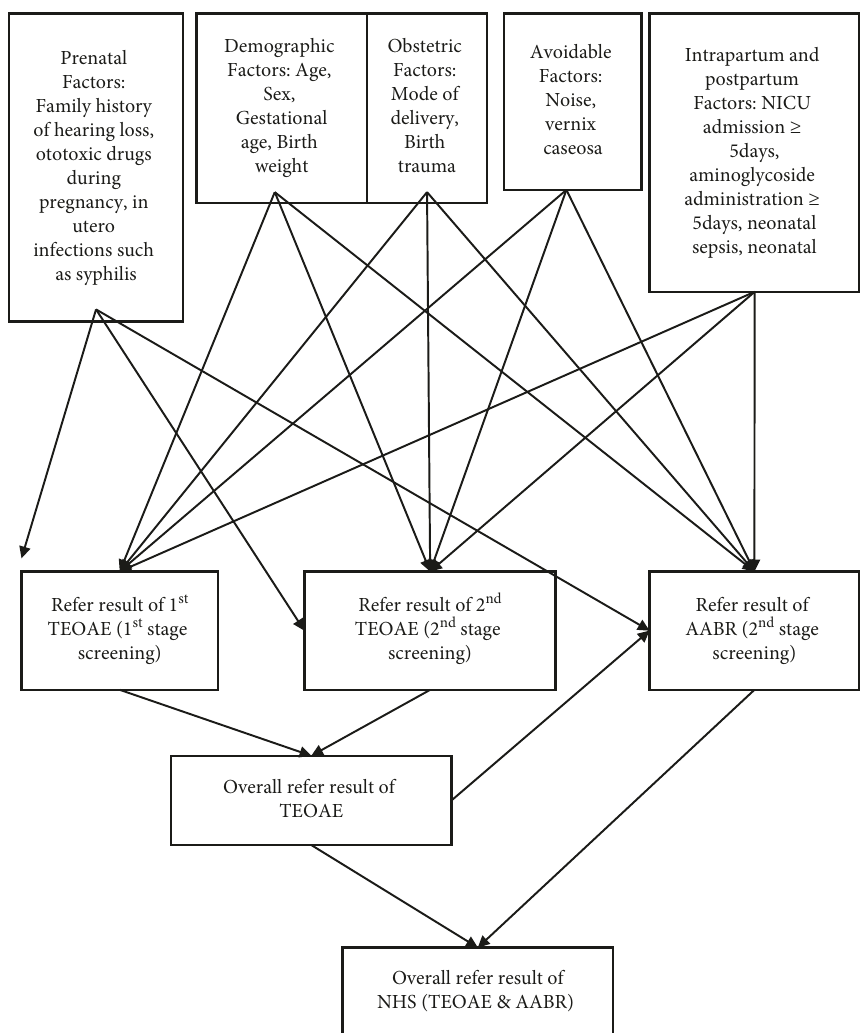
Figure 1: Data collection tool includes semi-structured questionnaire which includes demographic, prenatal, obstetric, intrapartum, and postpartum factors. Screening stages and its process